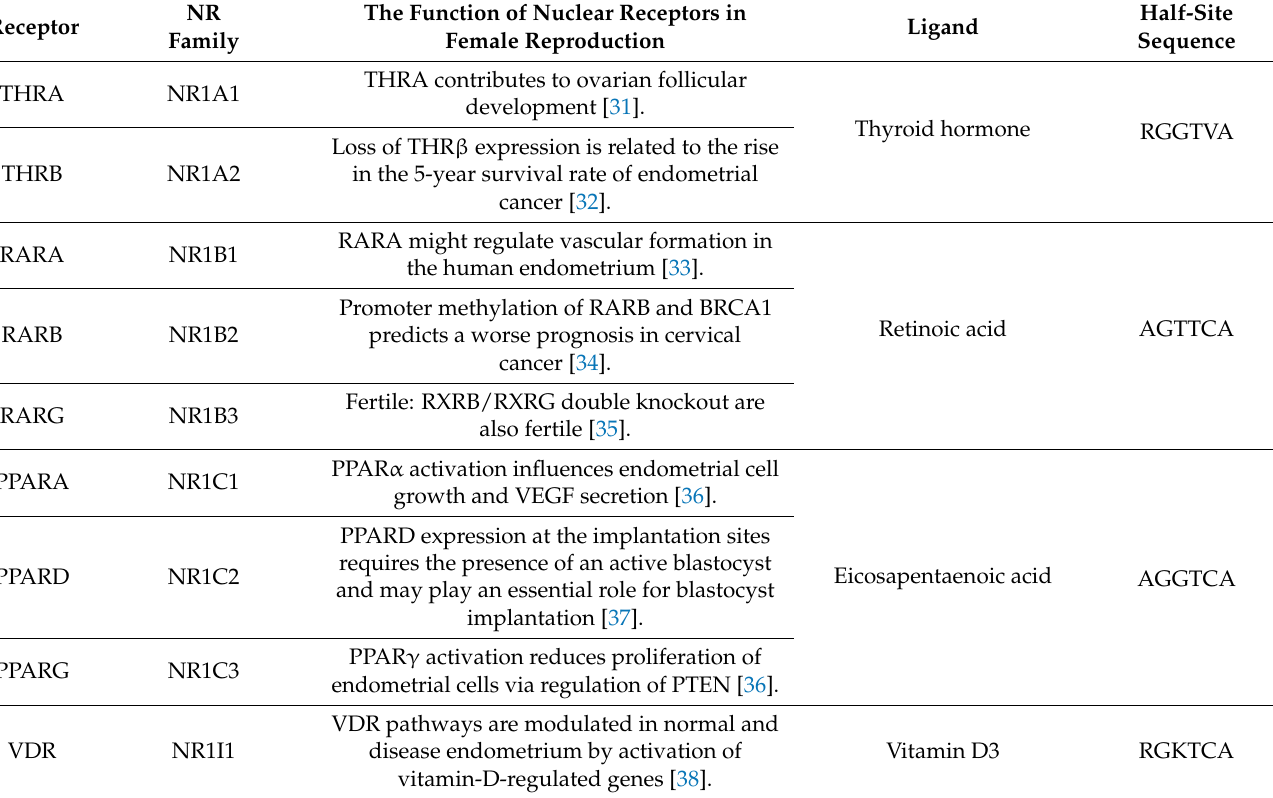
Table 1. Nuclear receptors sharing the same DNA consensus sequence and their role in female reproduction. HRE usually consists of two consistent palindromes (mirror images) or directly repeated hexamers. The palindromes are also referred to as “half-site”, because each site binds to a monomer of the receptor. Typically, TRE, PPARE, RXRE, VDRE, and ERE in the promoter regions of downstream genes contain two half-site sequences AGGTCA in a palindromic repeat, and the direct or inverted repeat arrangement can be recognized by their receptor. GRE, PRE, MRE, and ARE